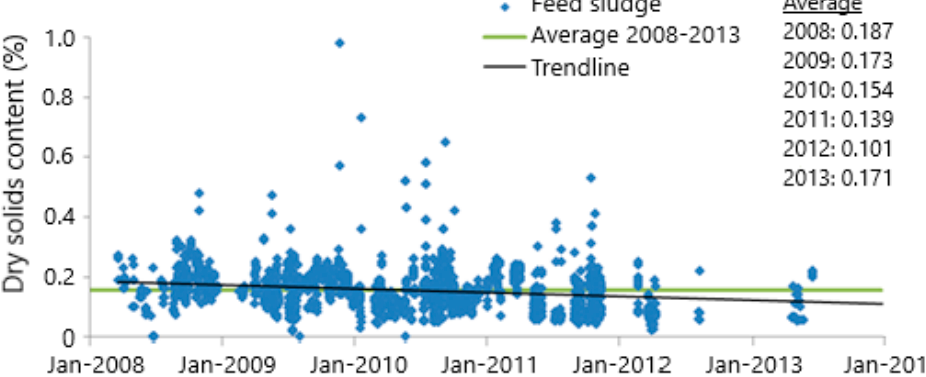
Figure 9. Dry solids (%) in the feed sludge at the Hanningfield WW [53]. Table 4. STRB feed sludge characteristics at the Whitacre and Hanningfield WW (England). Both facilities utilize ferric sulphate as a coagulant (P = pilot, F = full-scale, WW = Water Works) [53,58,60].